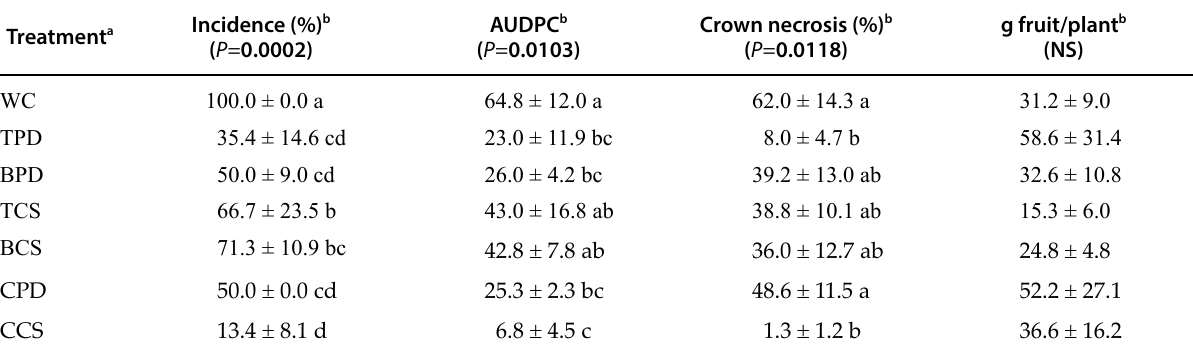
Table 3. Means of disease incidence, AUDPC, proportions of crown necrosis and weights of fruit after application of differ - ent biological and chemical treatments for control of charcoal rot caused by Macrophomina phaseolina in strawberry plants cv. Fortuna under field